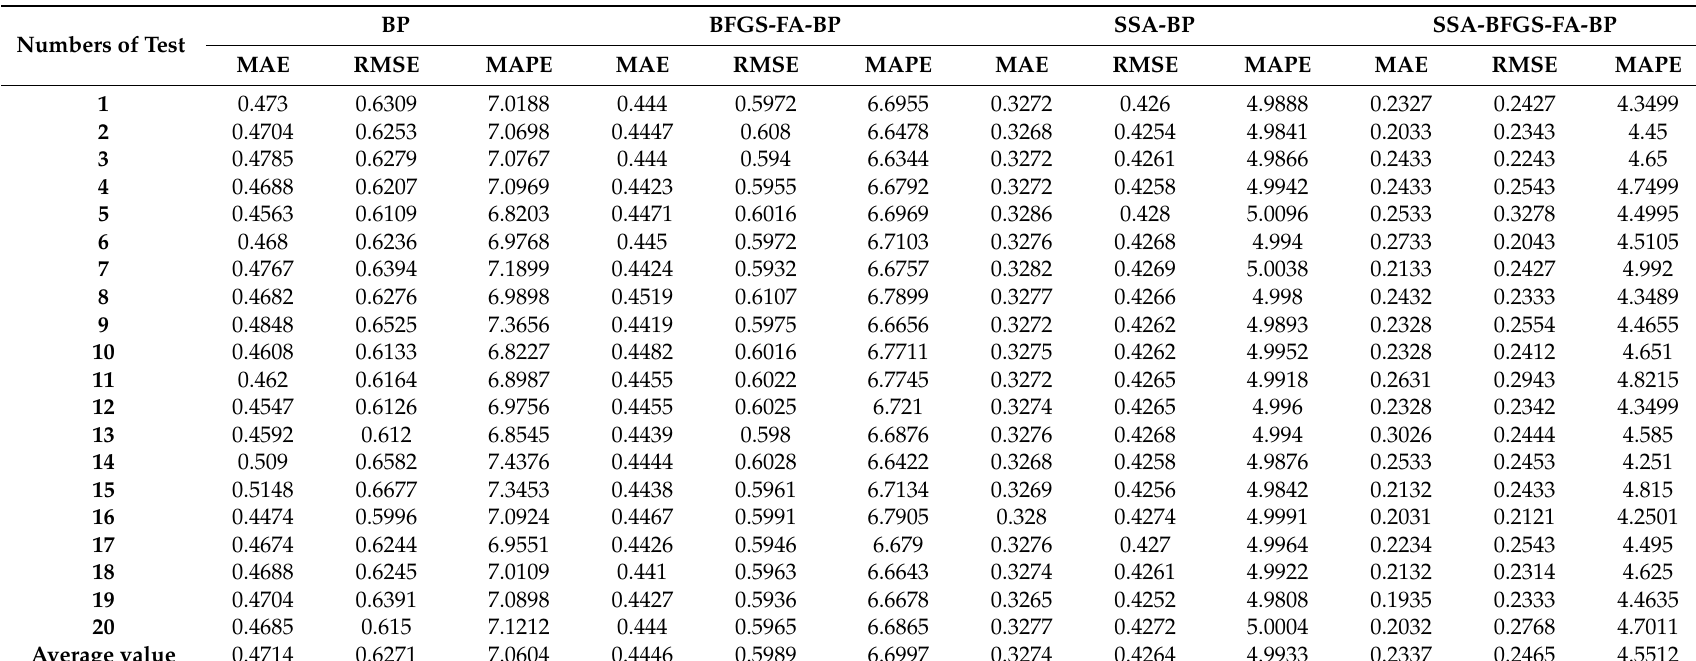
Table 8. MAE, RMSE, and MAPE of site 2 for each forecasting